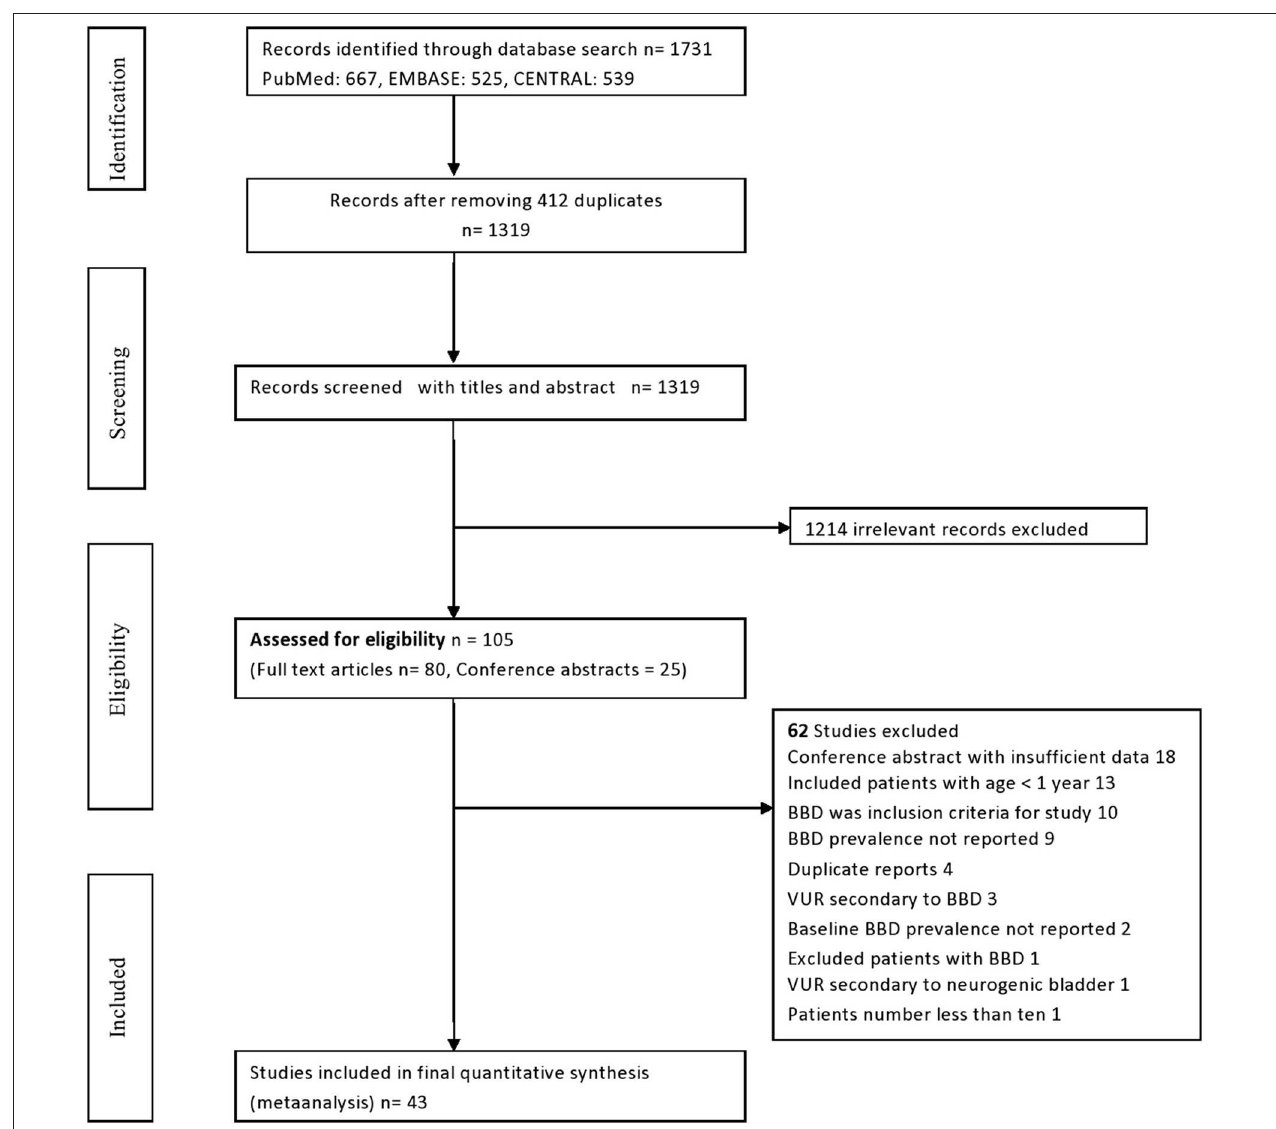
FIGURE 1 | Systematic review flow diagram for selection of